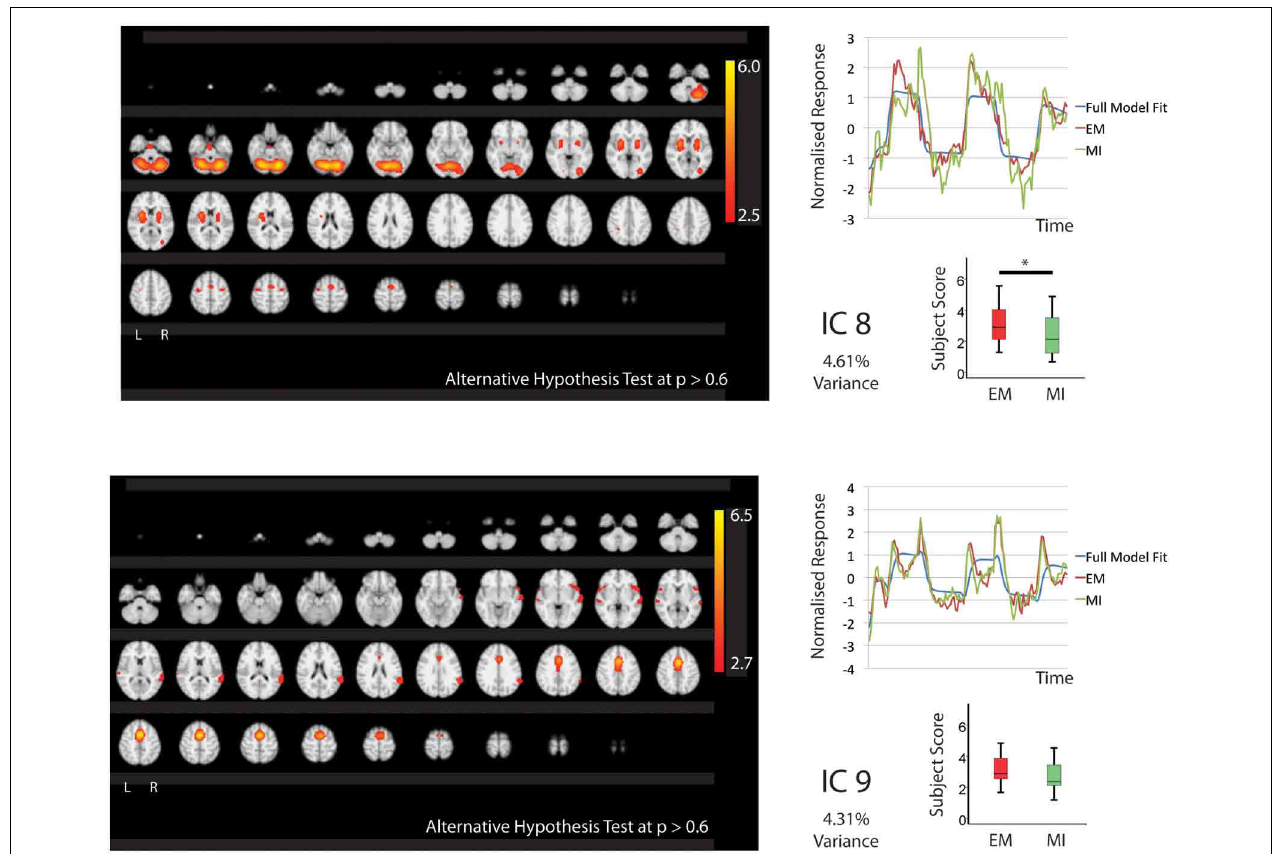
FIGURE 2 | The figures show the involvement of each IC across the whole brain with a standard threshold of p > 0 . 6 (alternative Hypothesis test) and the variance is accounts for out of the total explained variance. The scales show the transformed z -score, orange is activation, blue is deactivation. The normalized time course